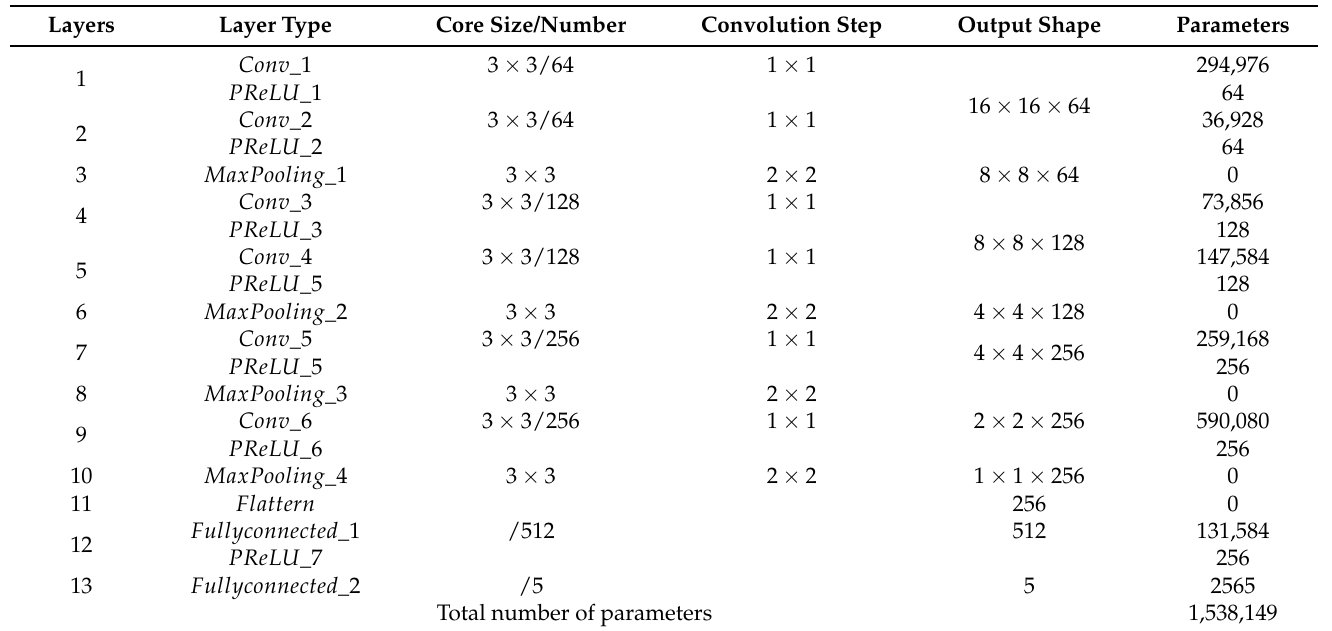
Table 3. The parameters and structure of our proposed network with the input data size of 16 × 16 ×